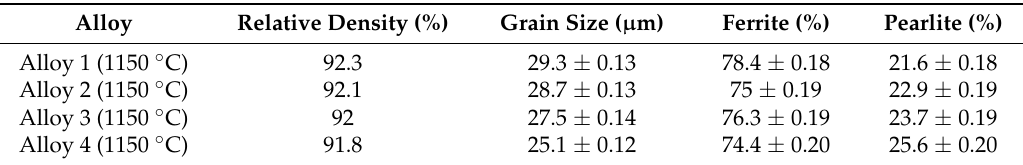
Table 3. Relative density, mean linear intercept grain sizes and volume fractions of ferrite and pearlite phases in non-alloyed and microalloyed PM specimens.